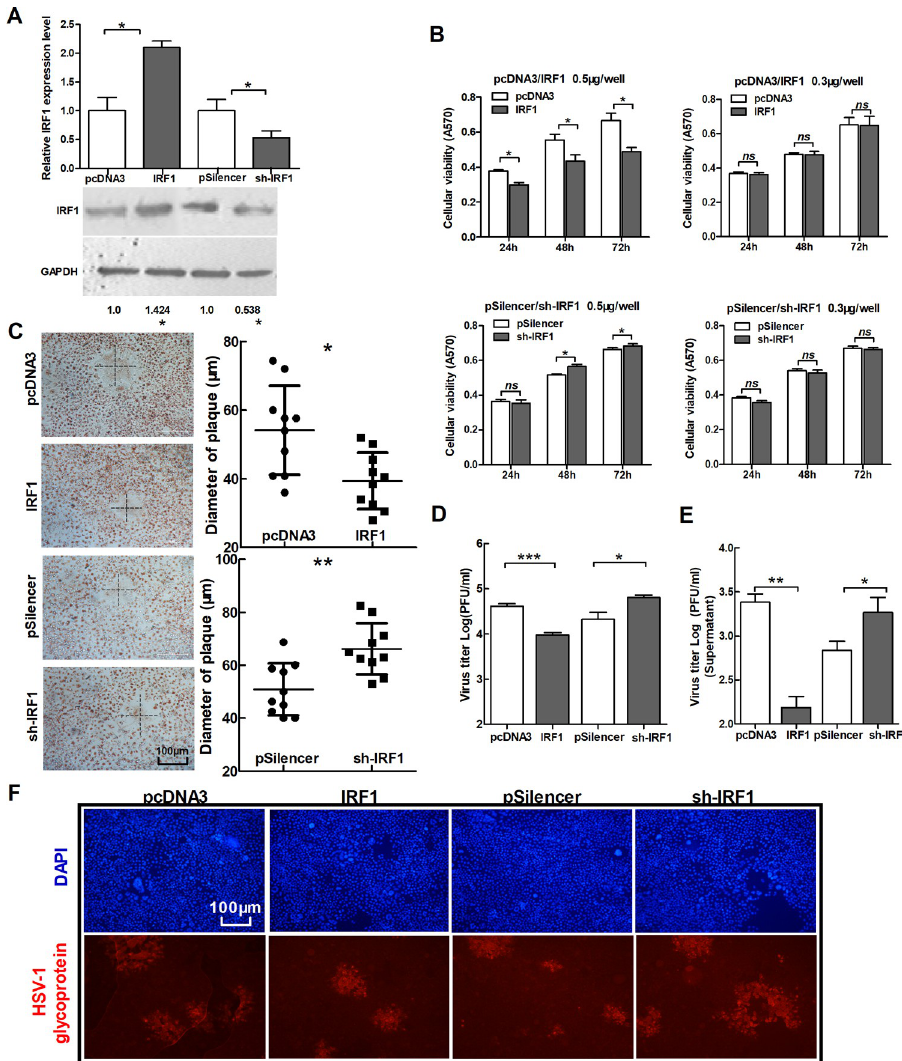
Fig 3. IRF1 suppresses the replication of HSV-1. (A) HeLa cells were transfected with IRF1, sh-IRF1 and control vectors, respectively. Total RNA was extracted and analyzed for IRF1 mRNA by quantitative real-time PCR. The cell lysate was extracted and analyzed for IRF1 expression by Western blot. (B) HeLa cells were transfected as indicated in (A), MTT assay of cell viability was conducted at 24 h, 48 h and 72 h post-transfection. To up-regulate IRF1, two doses of vectors were used for transfection, 0.5 μ g/well and 0.3 μ g/well. Another group was transfected with sh-IRF1 and its control vector in the same way. (C–F) HeLa cells were transfected as indicated in (A), 24 h post-transfection, cells were infected with HSV-1 at 0.01 PFU/cell. At 48 h post-infection, cells were stained with neutral red. The mean radius of the cytopathic area was measured. The scale bar represents 100 μ m (C). Total viral yields (D) and Yield of progeny virions from the culture supernatant (E) were determined by standard plaque assays. Level of glycoprotein expression was determined by immunofluorescence assay (F). All data represent the mean value ± SD of at least three independent experiments. � : p < 0.05; �� : p < 0.01; ��� : p < 0.001; ns: No significant differences by Student’s t